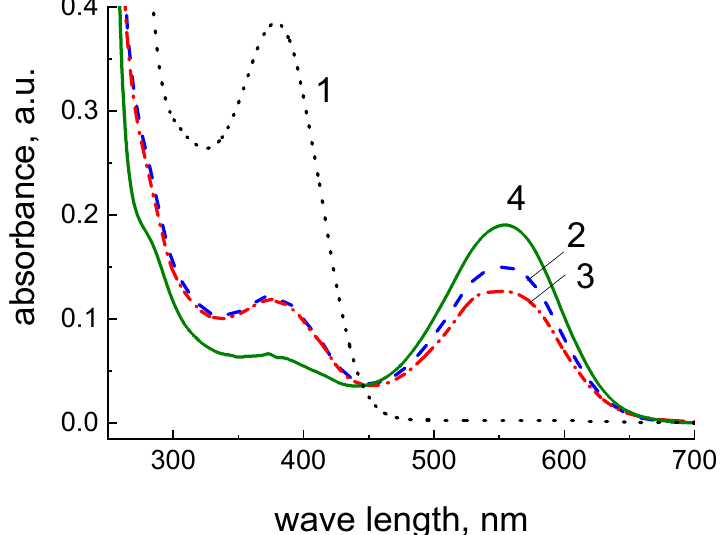
Figure 11. Electronic absorption spectra of MTT reagent (curve 4 ) and formazan solutions in DMSO obtained after using a culture plastic ( 1 ), a pure chitosan film ( 2 ), and the composite film containing 2.5 wt.% SWCNT ( 3 ) as substrates.